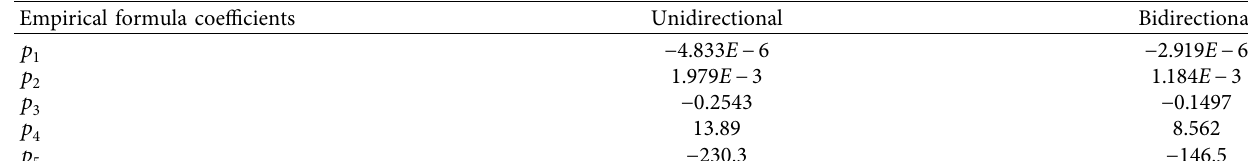
Figure 12: The P − M characteristic curves of pneumatic soft-bodied bionic basic units for variable angle. Table 8: Empirical formula coefficients of P − M characteristic curves.